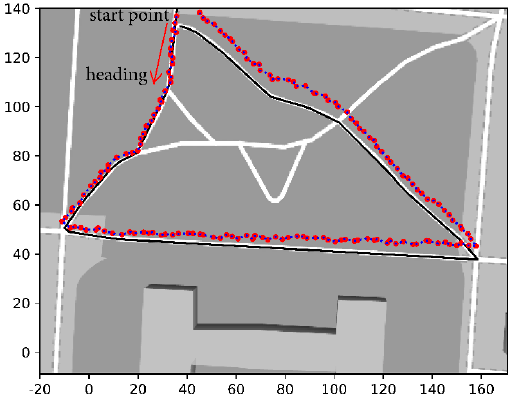
Figure 10. Location results from the pedestrian dead reckoning (PDR) algorithm.